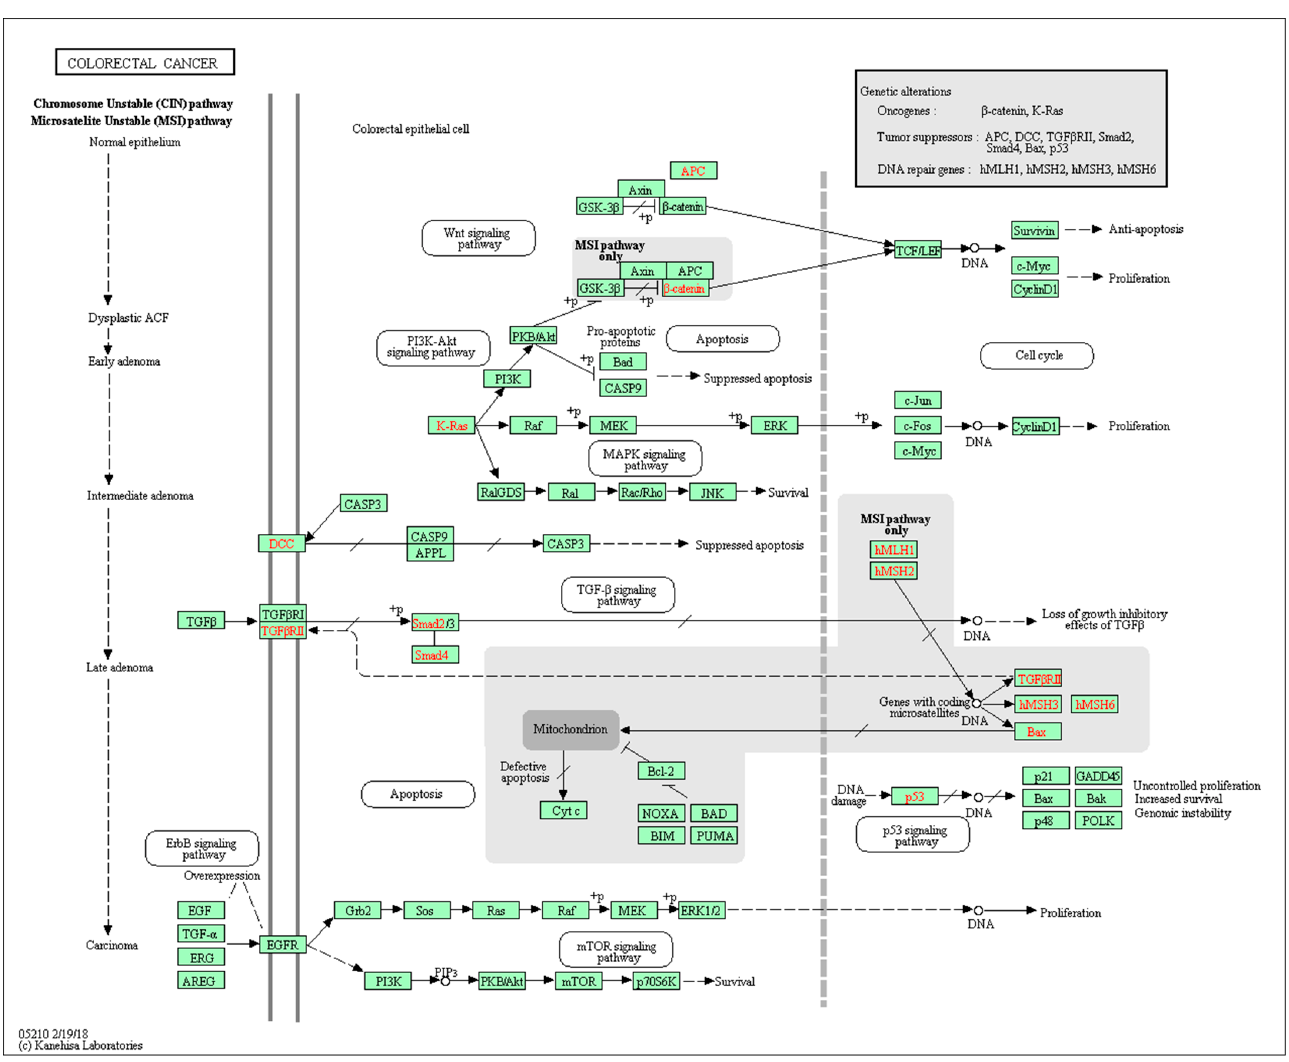
Figure 3. A pathway involved in proteoglycans in cancer (colorectal cancer, Homo sapiens ). Re- printed with permission from